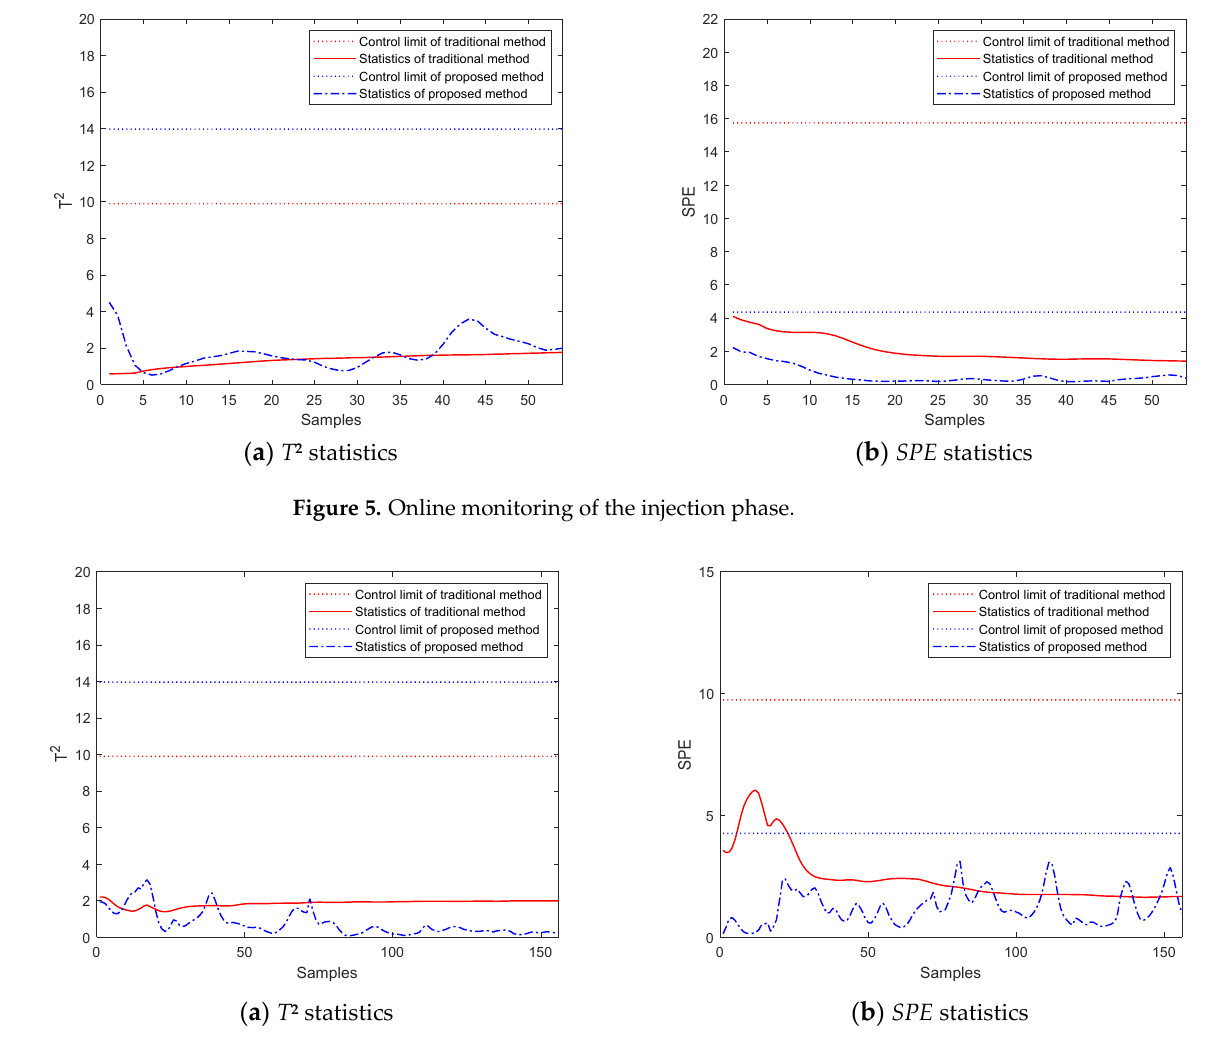
Figure 6. Online monitoring of the packing-holding phase.